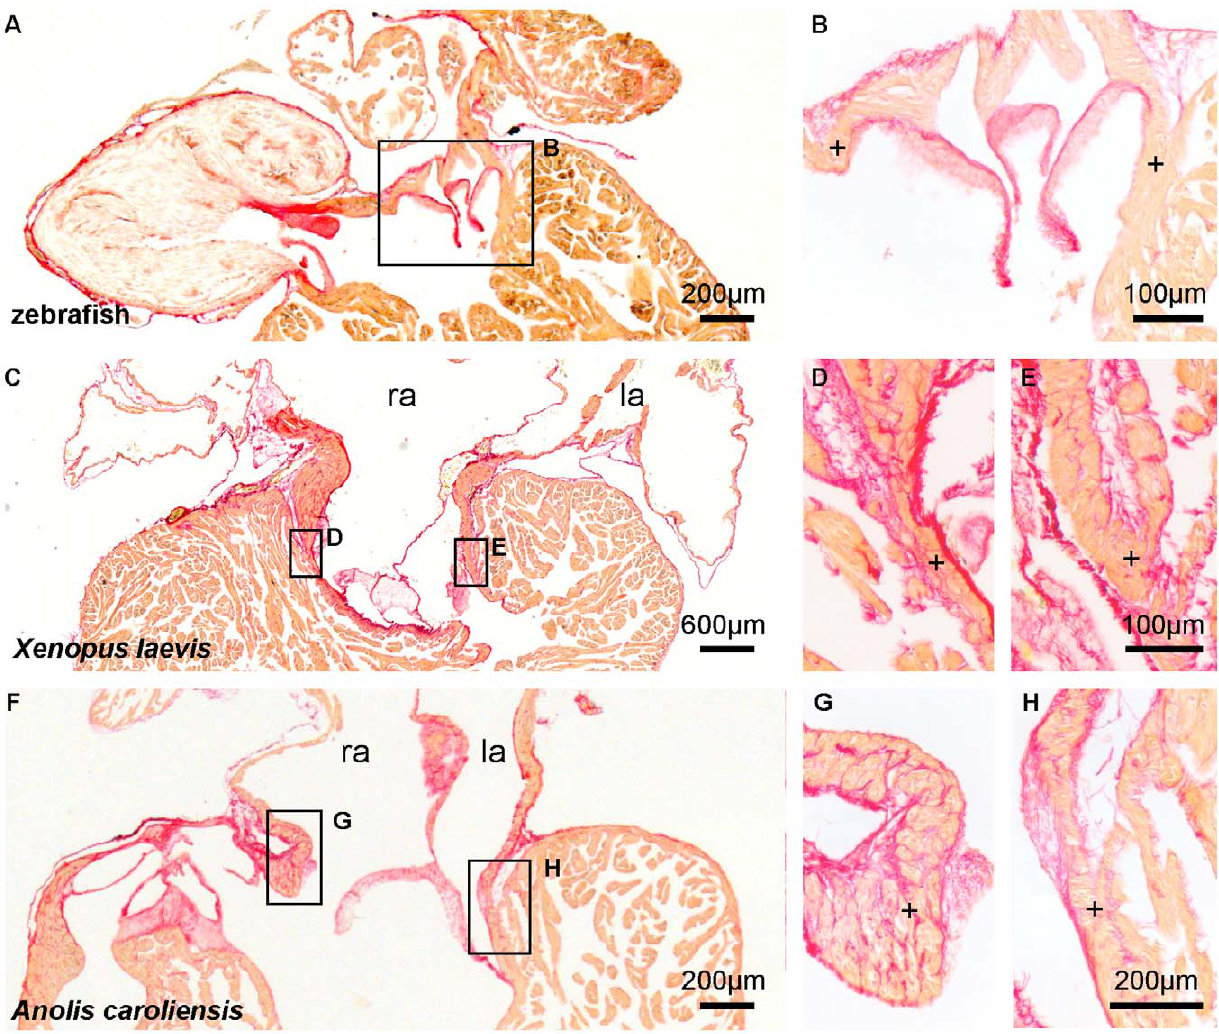
Figure 2. The atrioventricular junction in ectotherms is not interrupted by an insulating plane. Picro-sirius red stain for collagen (red) on 10 m m sections of hearts of adult ectotherms showing the atrioventricular canal to be in full communication ( + ) with the ventricle. l(r)a, left(right) atrium.